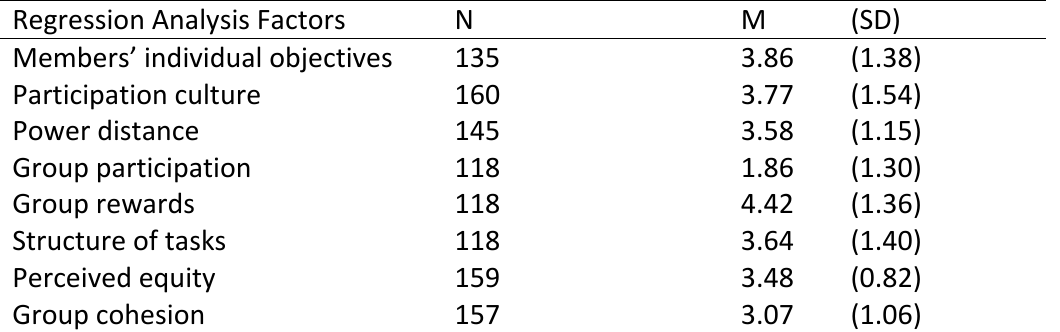
Descriptive statistics for factors/dimensions Regression Analysis Factors